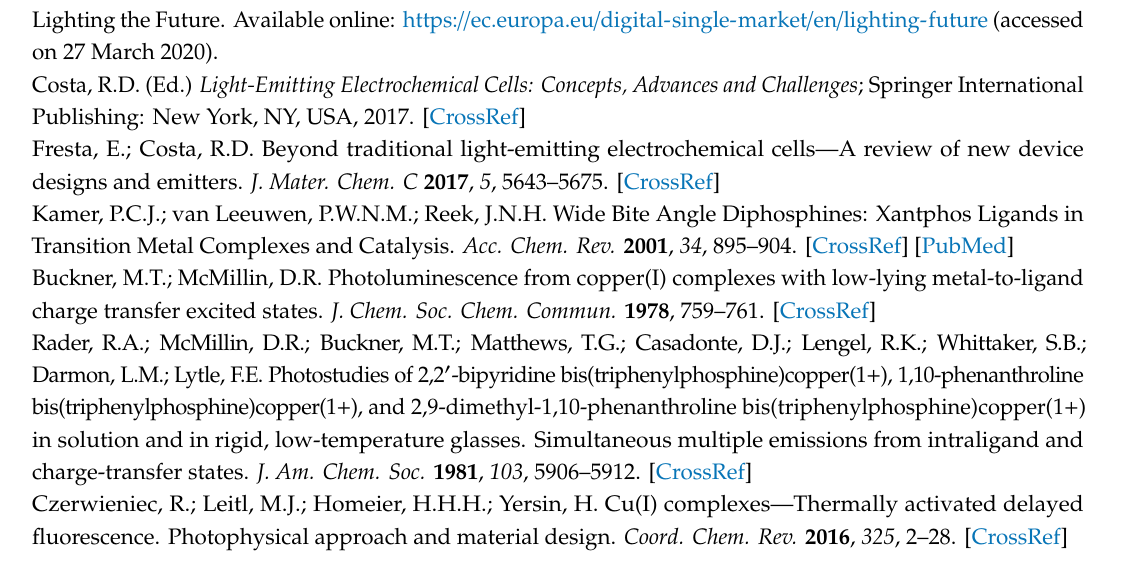
Figure S1: Electrospray mass spectrum of 6-Cl-6 (cid:48) -Mebpy; Figures S2–S4: NMR spectra of 6-Cl-6 (cid:48) -Mebpy; Figures S5–S6: Electrospray mass spectra of [Cu(POP)(6-Cl-6 (cid:48) -Mebpy)][PF 6 ] and [Cu(xantphos)(6-Cl-6 (cid:48) -Mebpy)][PF 6 ]; Figures S7–S11: NMR spectra of the complexes; Figures S12–S14: Additional structural figures; Figures S15–S16: Cyclic voltammograms. Cif and CheckCif files of [Cu(POP)(6-Cl-6 (cid:48) -Mebpy)][PF 6 ] and [Cu(xantphos)(6-Cl-6 (cid:48) -Mebpy)][PF 6